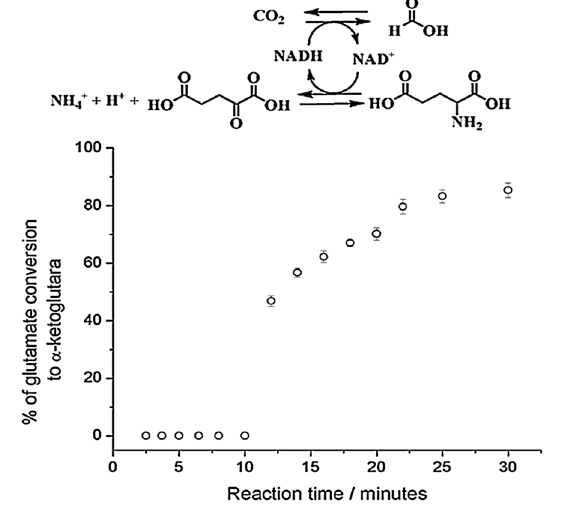
Figure 4 - Bi-enzymatic system involving MagNP-APTS/FDH and MagNP-APTS/Glyoxyl-Agarose/GDH. The reaction was evaluated by the conversion of glutamate to α -ketoglutarate by a colorimetric ninhydrin